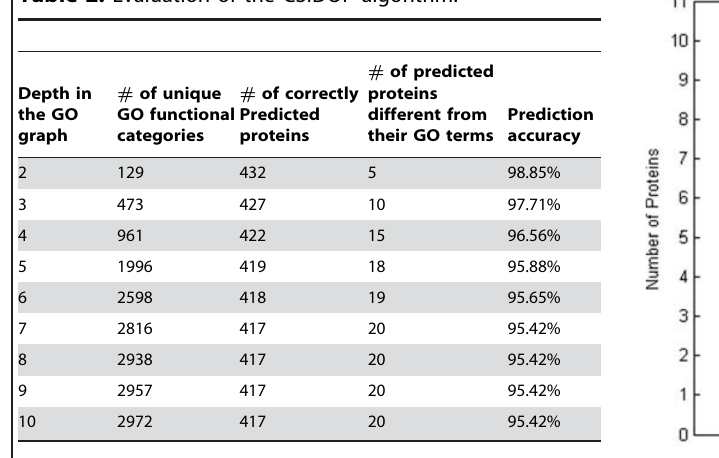
Table 2. Evaluation of the CSIDOP algorithm.